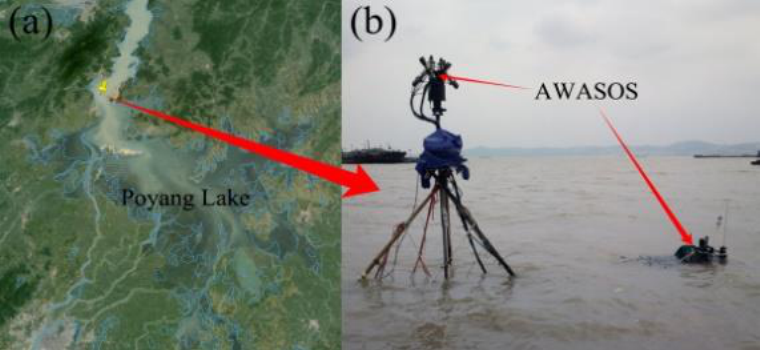
Figure 7. ( a ) The deployment site (29°26.75′ N, 116°3.1′ E) and ( b ) the real scene in Poyang Lake.